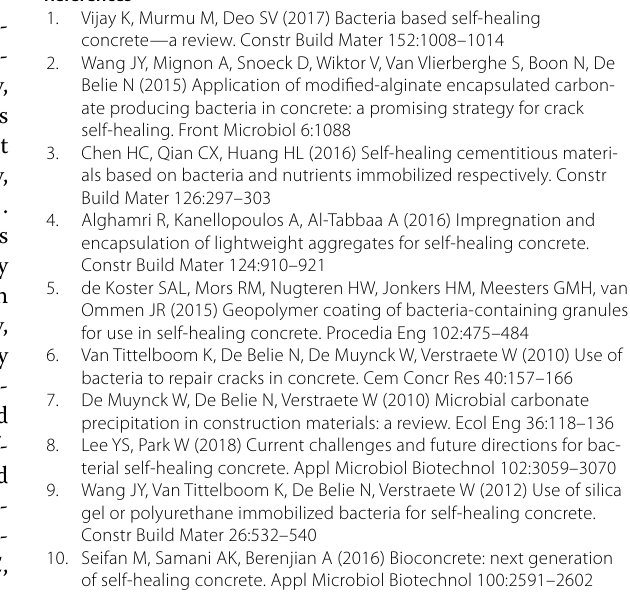
Fig. 4 Change in calcium ion concentration with time. Free bacteria (1.0 10 6 cells/mL) and EC-immobilized bacteria (1.0 × of dry EC) were used. Expanded clay was submerged into bacterial solution of 1.0 10 8 cell/mL and processed as described in “Materials × and methods” section. No carbonatogenesis activity was observed for control medium and EC